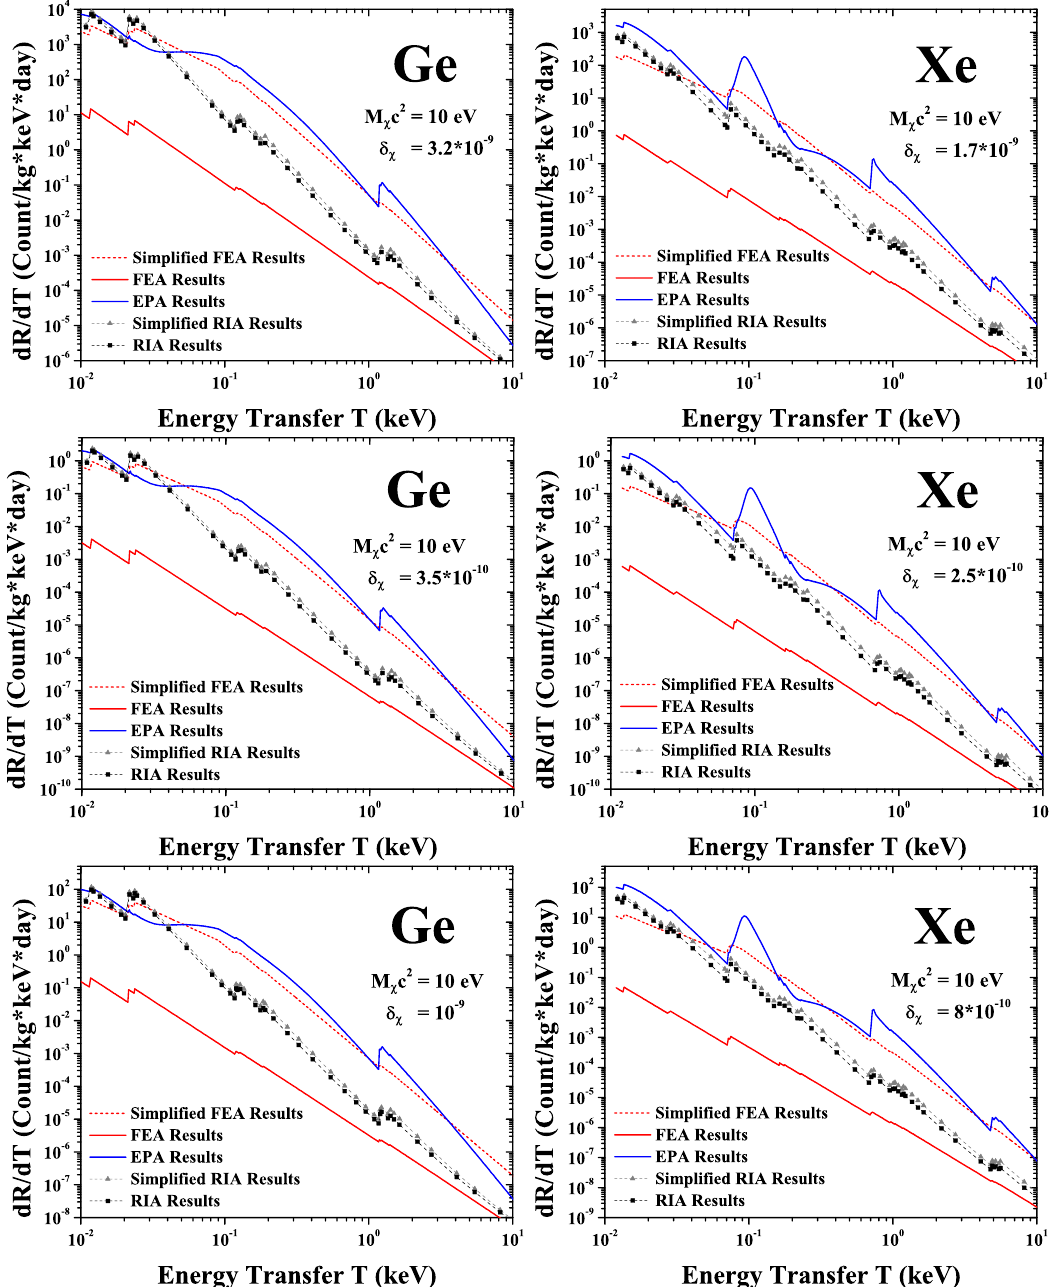
Figure 10 . The differential reaction event rates for the atomic ionization process induced by millicharged particles in HPGe and LXe detectors. The mass of millicharged dark matter particle is set as m is chosen such that the reaction event rates in HPGe 2 = 10 eV, and its millicharge δ χ c χ and LXe detectors match the experimental background levels for next-generation experiments, respectively. In this figure, the horizontal axis represents the energy transfer T , and the vertical axis represents the differential event rate dR/dT in unit of cpkkd. The same as in figure 6 and figure 9, the red solid lines correspond to the FEA results; red dashed lines represent the simplified FEA results; blue lines stand for the EPA results; black squares display the RIA results; gray triangles show the simplified RIA